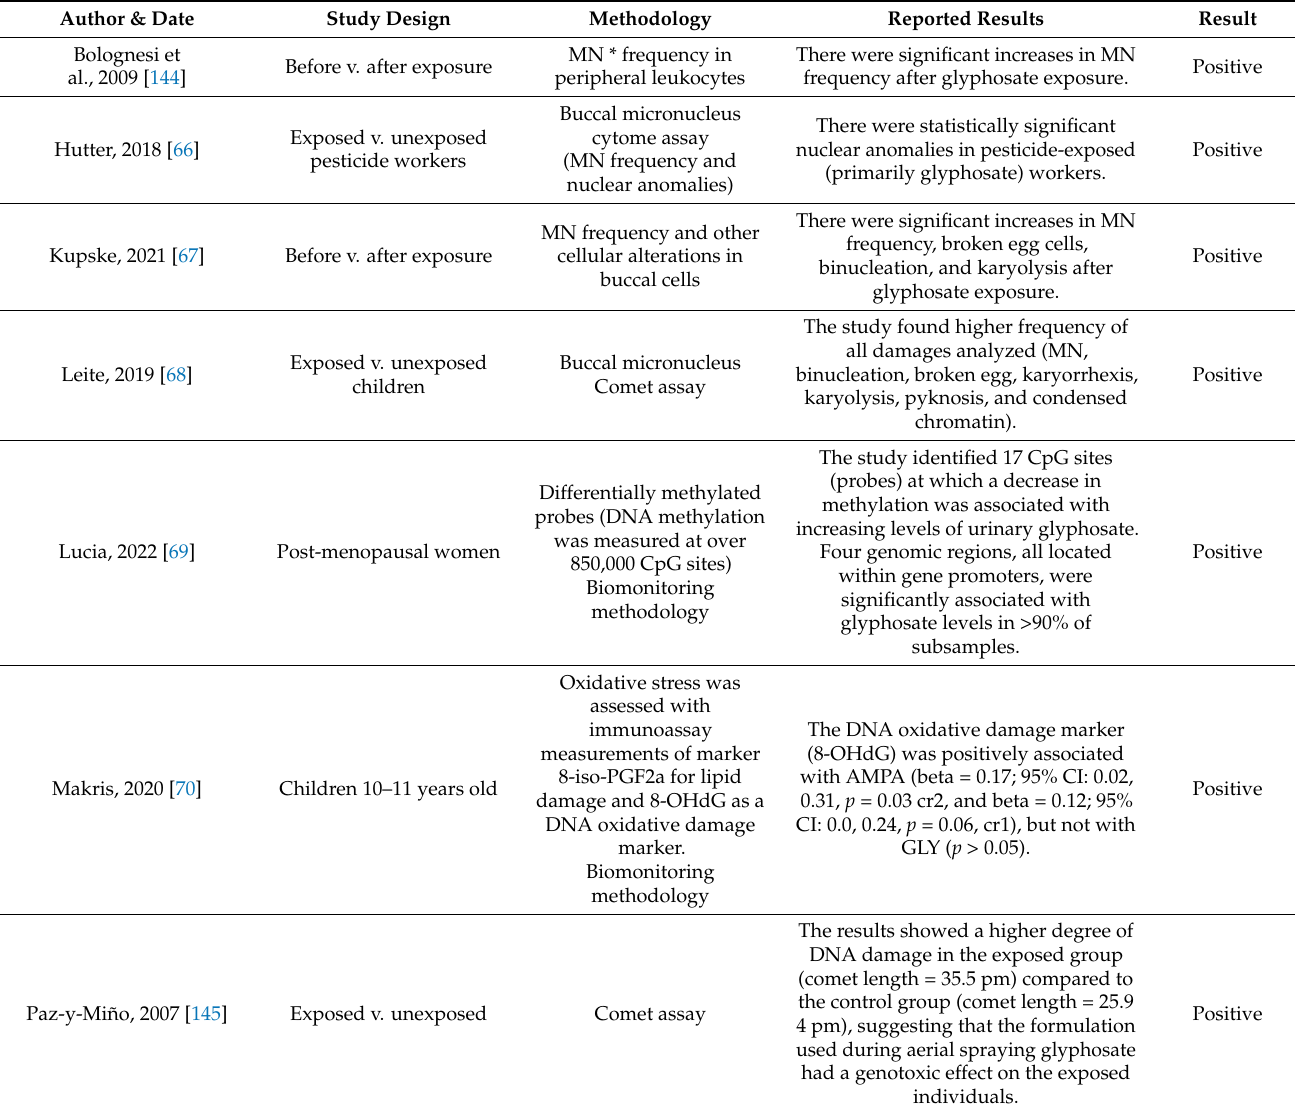
Table 2. Summary of Seven Human In Vivo Genotoxicity